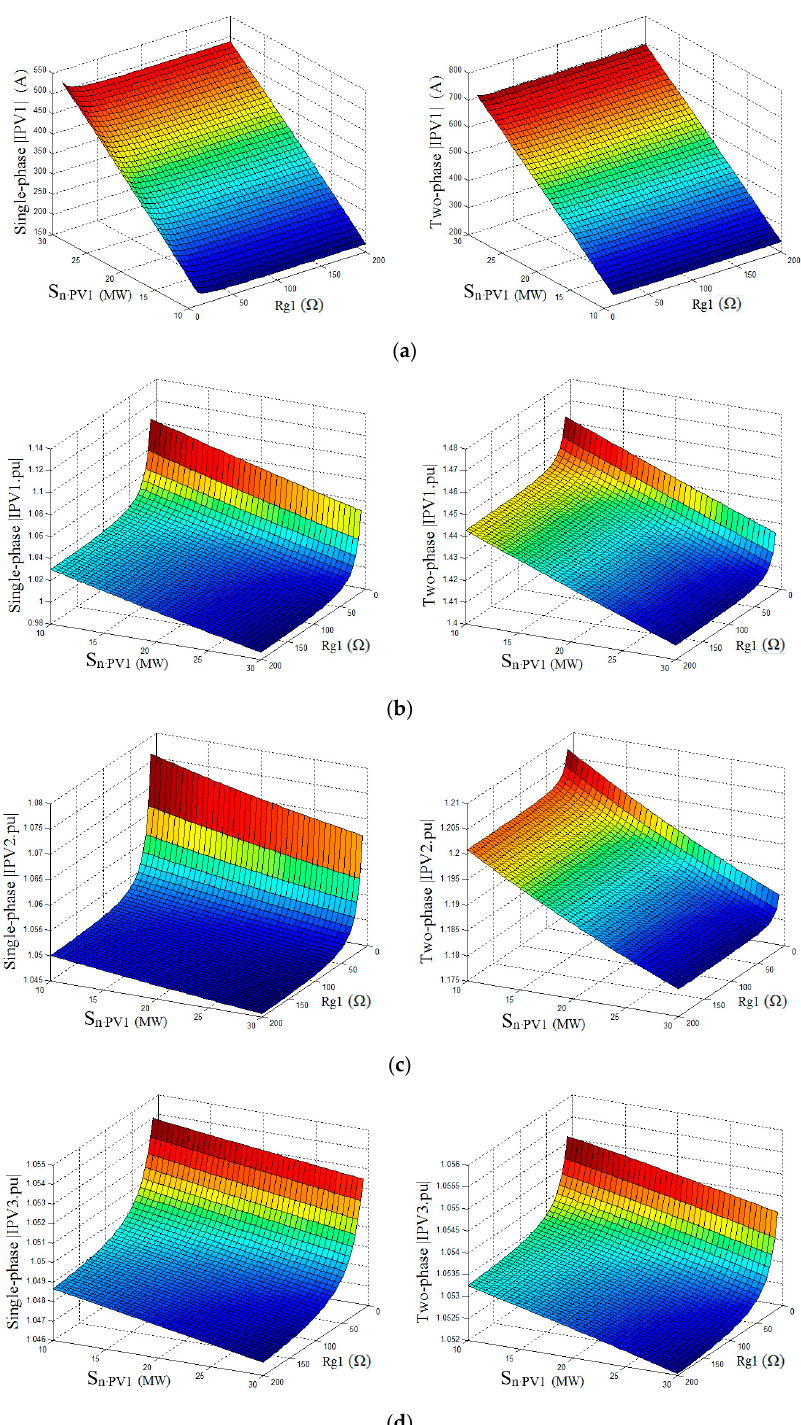
Figure 11. Characteristic of the PV power supply output current with the ground fault at the end of L3. ( a ) Output current of PV1, | I PV1 |; ( b ) output current per-unit of PV1, I PV1.PU ; ( c ) output current per-unit of PV2, I PV2.PU ; ( d ) output current per-unit of PV3, I PV3.PU .